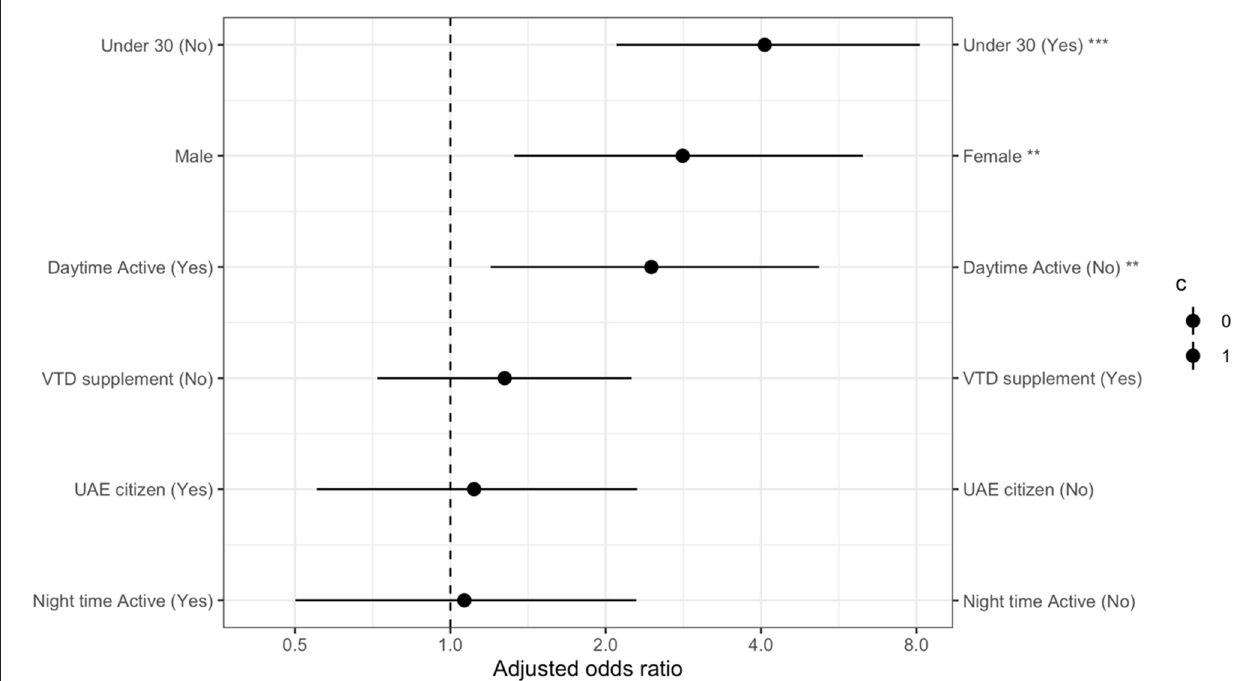
FIGURE 1 | Multivariate logistic regression model analysis for higher risk of clinically significant depressive symptoms with adjusted odds ratios for all variables.